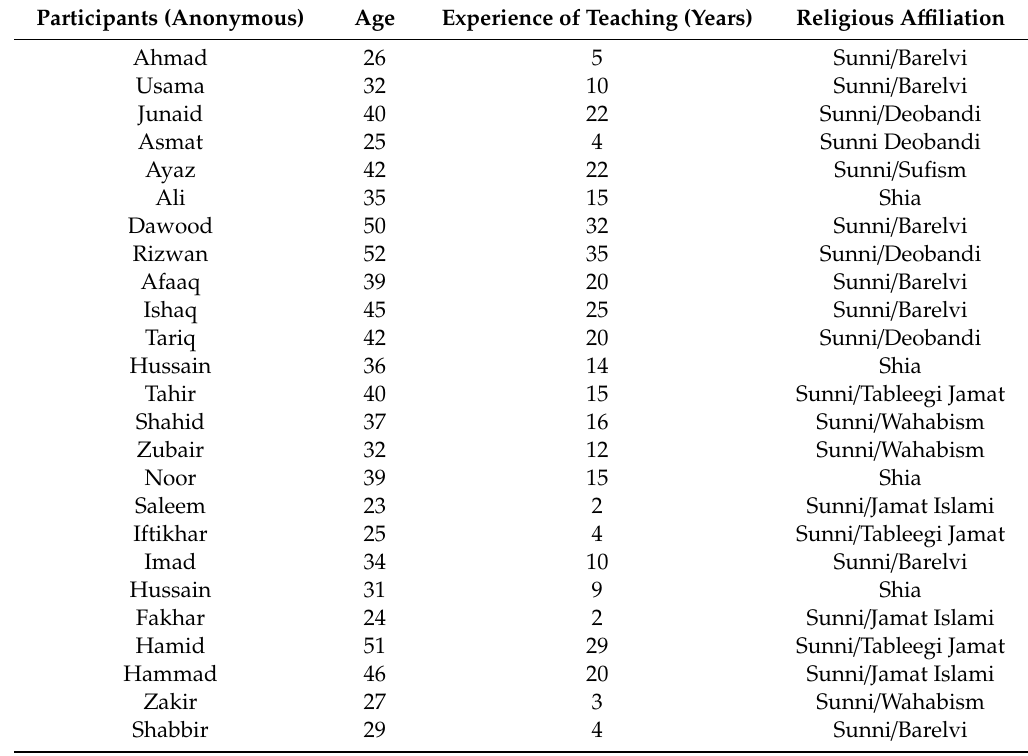
Table 3. Background information on the